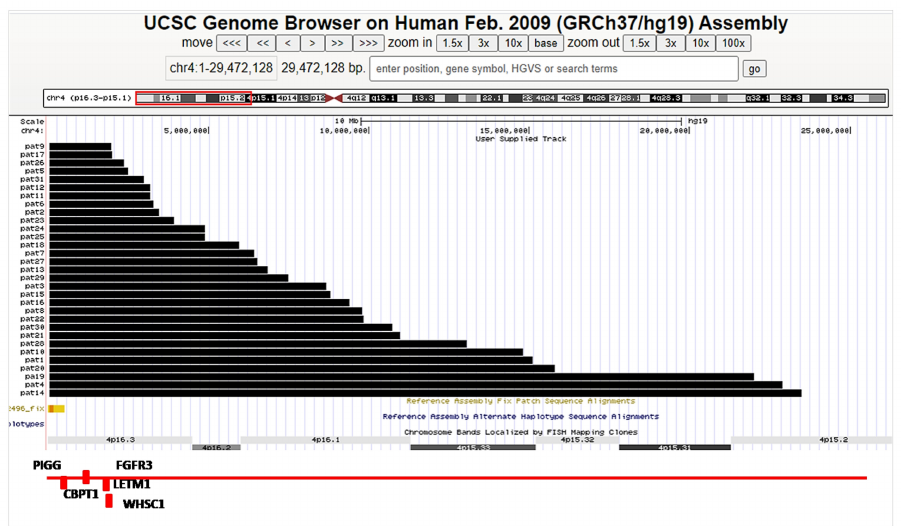
Figure 2. Deletions (black bars) observed in unrelated individuals with Wolf-Hirschhorn syndrome. *, cases with additional rearrangements. Location of 4p cytogenetic bands and known genes of their critical region (#) produced using UCSC genome browser version GRCh37 / hg19 (International Human Genome Sequencing Consortium 2004).